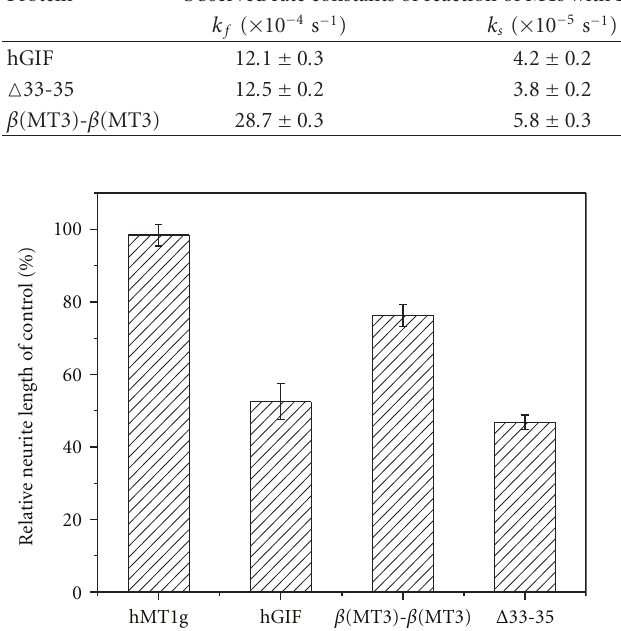
Figure 4: E ff ect of Zn 2+ -reconstituted hGIF, the (cid:2) 33-35 mutant, and the β (MT3)- β (MT3) mutant on neurite extension in the presence of adult rat brain extract (150 μ g/mL) after 3 days, determined by the average neurite length of 60 neurons. As a comparison, the result of hMT1g (a human MT1 isoform where the segment is 20 KCK 22 ) under the same conditions was also shown. Error bars represent standard error